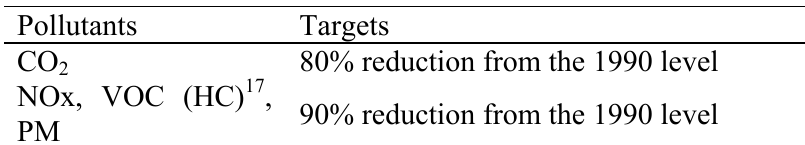
Table 12. Targets in the Case Study for Aichi Prefecture